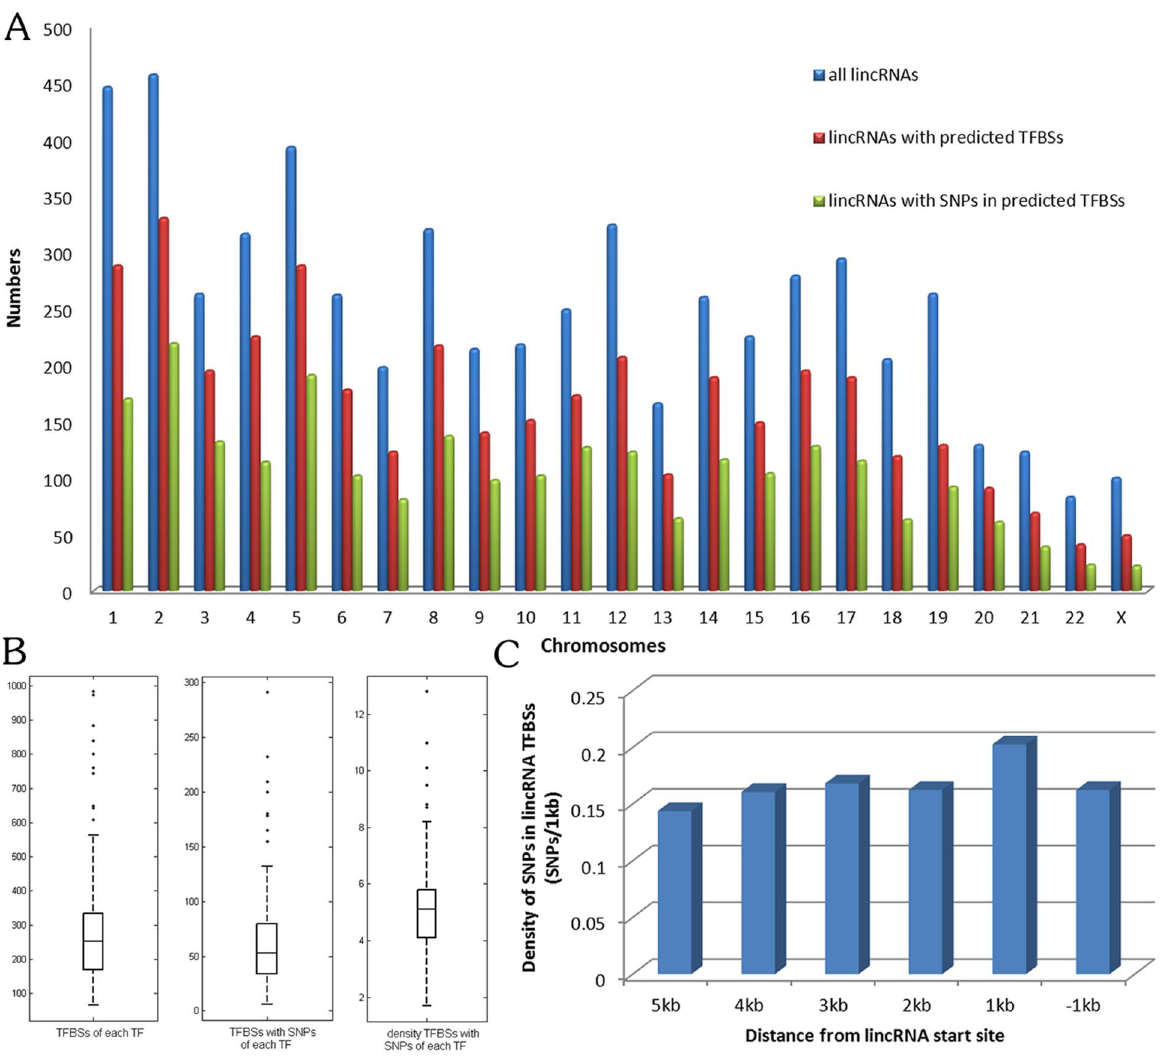
Figure 2. SNPs in human lincRNA TFBSs. ( A ) The number distribution of lincRNAs classified as chromosomes. Blue bars represent all lincRNAs. Red bars represent lincRNAs have TFBSs in their promoter regions. Green bars represent lincRNAs have SNPs in their TFBSs. (B) Statistics of lincRNA TFBSs with SNPs for each transcription factor. The quantity of lincRNA TFBSs for each transcription factor (left). The quantity of lincRNA TFBSs with SNPs for each transcription factor (middle). Density of lincRNA TFBSs with SNPs for each transcription factor (right). (C) Distribution of SNPs in lincRNA TFBSs with respect to distance to the lincRNAs. The x-axis displays the 1 kb window within 5 kb upstream to 1 kb downstream region of the start site of lincRNA and the y-axis displays the fraction of SNPs in lincRNA TFBSs located within this